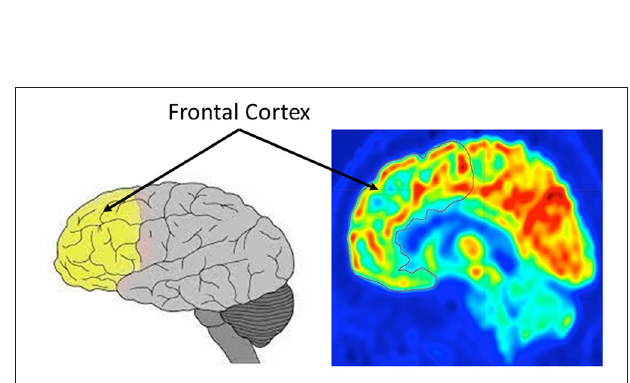
FIGURE 2 | The frontal cortex in the brain: the left is anatomical location, and the right is for 18 F-FDG positron emission tomography (PET) imaging.